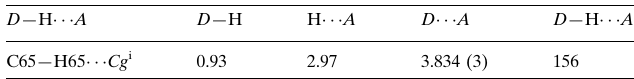
Hydrogen-bond geometry (A˚ , (cid:1) ). Cg is the centroid of the C31–C36